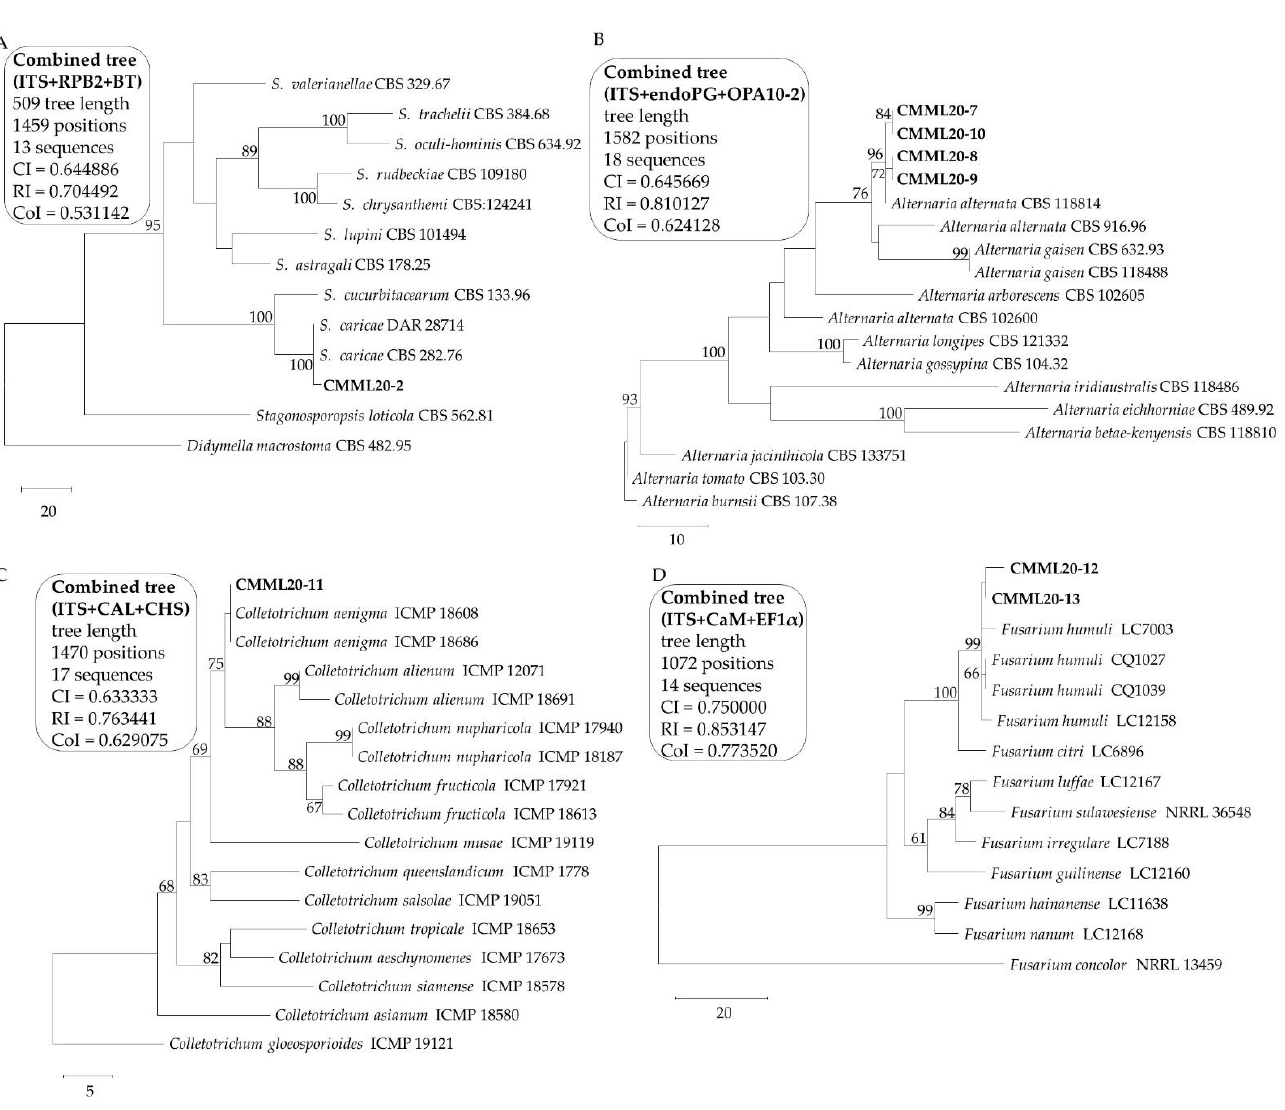
Figure 2. Phylogenetic tree constructed by the maximum parsimony method from alignment of combined datasets ( A ) CMML20 – 2, ITS, RPB2, and BT, ( B ) CMML20 – (7 – 10), ITS, endoPG, and OPA10-2, ( C ) CMML20 – (11 – 12), ITS, CAL, and CHS, ( D ) CMML2 – 12 CAL, CHS, EF1 α , RPB2, and BT. The percentage of replicate trees in which the associated taxa clustered together in the bootstrap test (1000 replicates) is shown next to the branches. Bootstrap values >50% are indicated above branches. All positions containing gaps and missing data were eliminated. The isolates in this study are marked in bold.